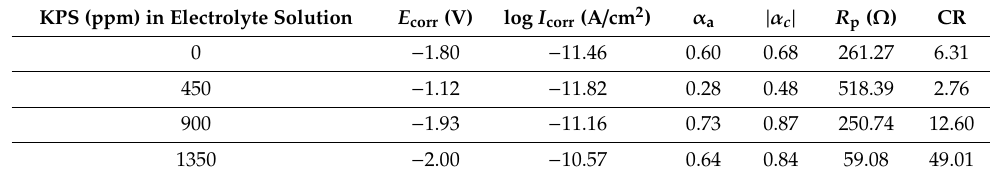
Figure 2. ( a ) Potentiodynamic polarization characteristics of the Zn anode in the electrolytes containing di ff erent concentrations of KPS using a scan rate of 0.07 mV / s within the potential range of − 0.5 to 0.5 V vs. the open-circuit potential (OCV). ( b ) Nyquist plots of EIS with fitted lines performed at the potential of 0 V in the frequency range from 0.01 Hz to 100 kHz with an AC amplitude of 10 mV of the electrolytes containing di ff erent concentrations of KPS. Table 1. Corrosion parameters obtained from the Tafel analysis for the Zn anode in the electrolytes containing di ff erent concentrations of KPS.